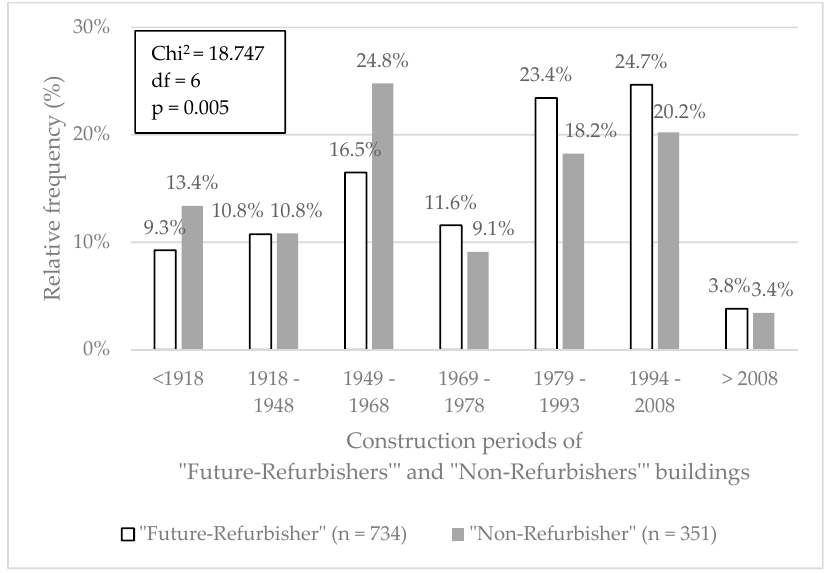
Figure 4. Construction periods of “Future-Refurbishers” and “Non-Refurbishers” buildings.